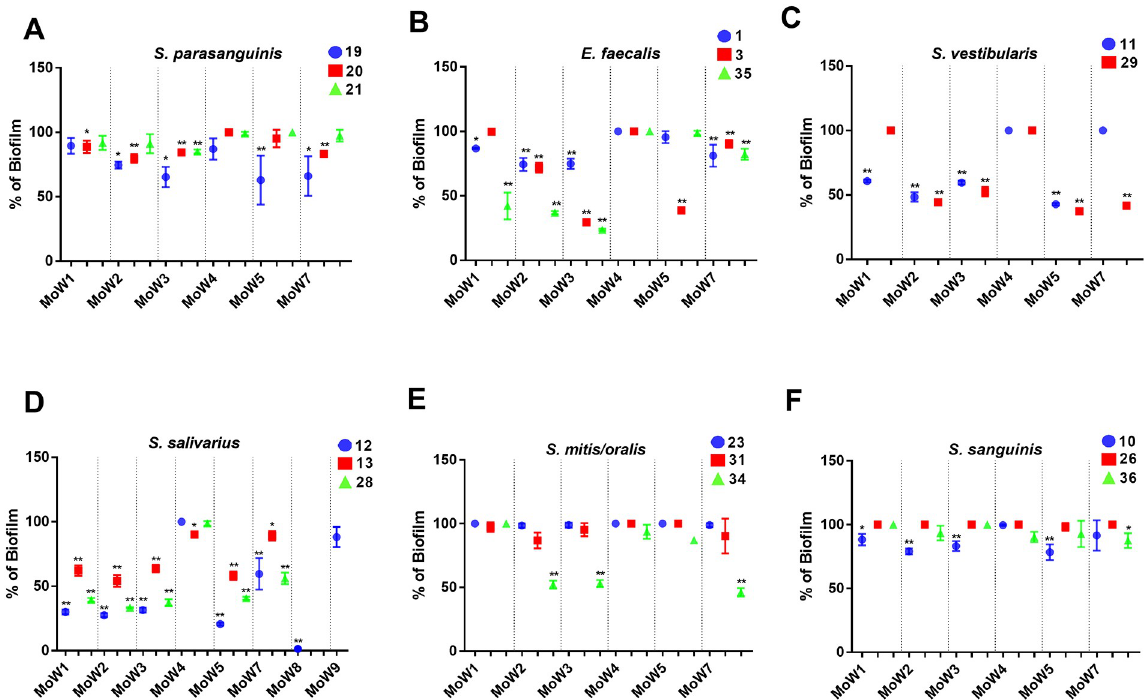
Fig 5. Effects of MoWs on viridans streptococci and E . faecalis biofilm production. Bacterial isolates, belonging to the species S . parasanguinis (A) , E . faecalis (B) , S . vestibularis (C) , S . salivarius (D) , S . mitis/oralis (E) and S . sanguinis (F) were treated for 1 minute with PBS or with MoWs, before being washed, suspended in BHI broth, seeded (1.5 x 10 7 CFU/ml) in 96-well plates and incubated at 37˚C for 48h to allow biofilm formation. Biofilm biomass was then assessed by CV assay and the results were expressed as percentage of biofilm production with respect to the 100% biofilm of PBS-treated bacteria. Each result is the mean value ± standard error of triplicate samples. � p < 0.05 or �� p < 0.001 indicate significant differences between MoWs-treated vs PBS-treated bacteria. MoW1: Curasept 0.20; MoW2: Dentosan Collutorio; MoW3: Meridol Collutorio; MoW4: Elmex Sensitive Professional; MoW5: Listerine Total Care Zero; MoW7: Parodontax; MoW8: Oral B; MoW9: PlaKKontrol Protezione